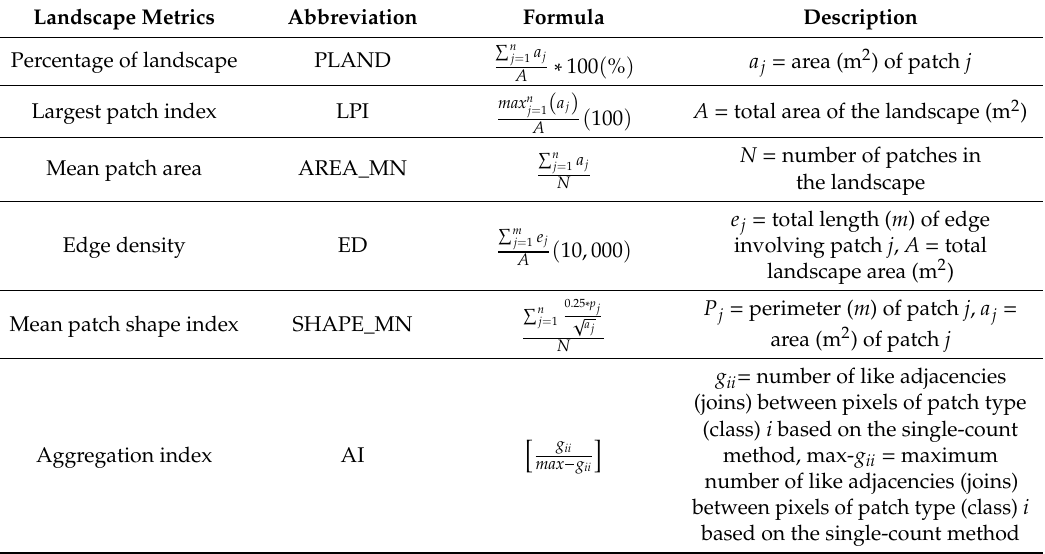
Table 2. Description of landscape metrics